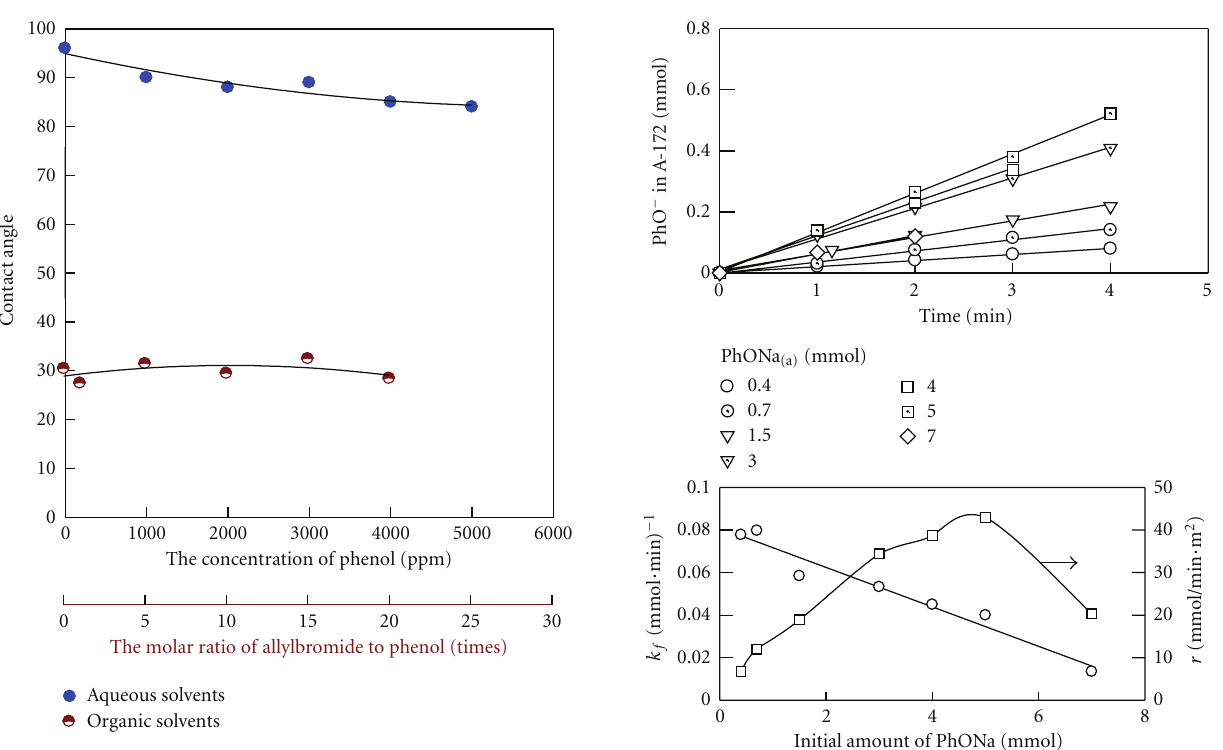
Figure 9: PhO − in A172 versus time and the e ff ect of PhONa on the forward ion-exchange rate. 65 ◦ C, 400 rpm, 30.2 cm 2 of A-172 membrane, aqueous phase 55 cm 3